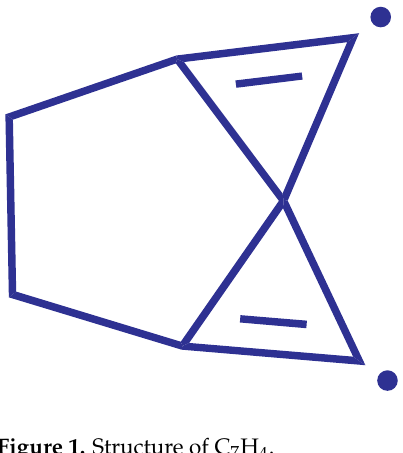
Figure 1. Structure of C 7 H 4